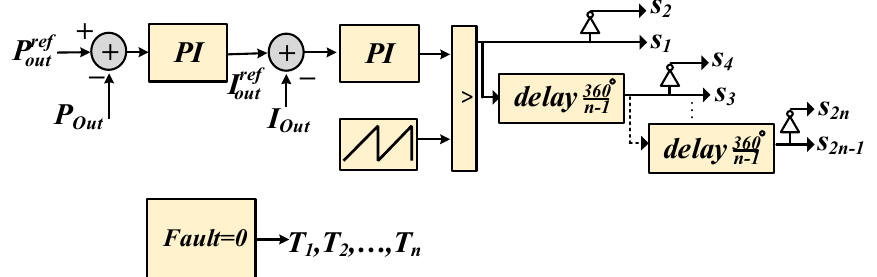
Figure 3. Fault–tolerant converter control during normal state.